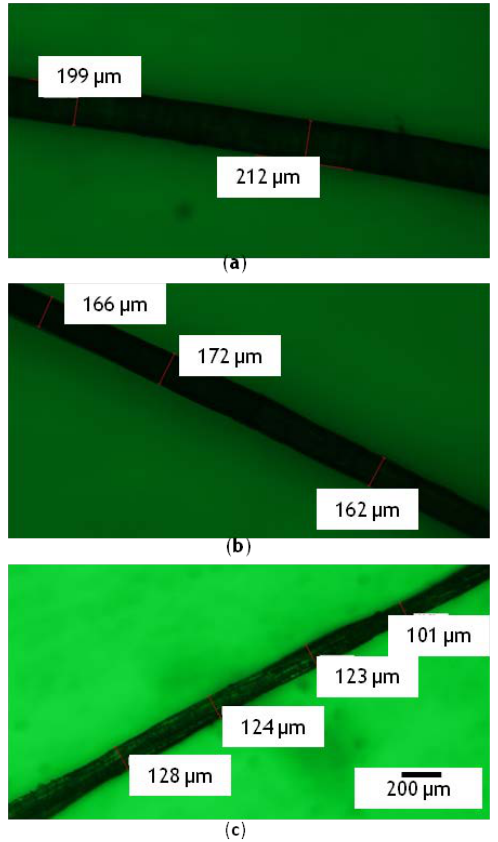
Figure 3. Optical micrographs of virgin banana fibers and their diameters: ( a ) untreated fibers; ( b ) fibers after Treatment 1; ( c ) fibers after Treatment 2.